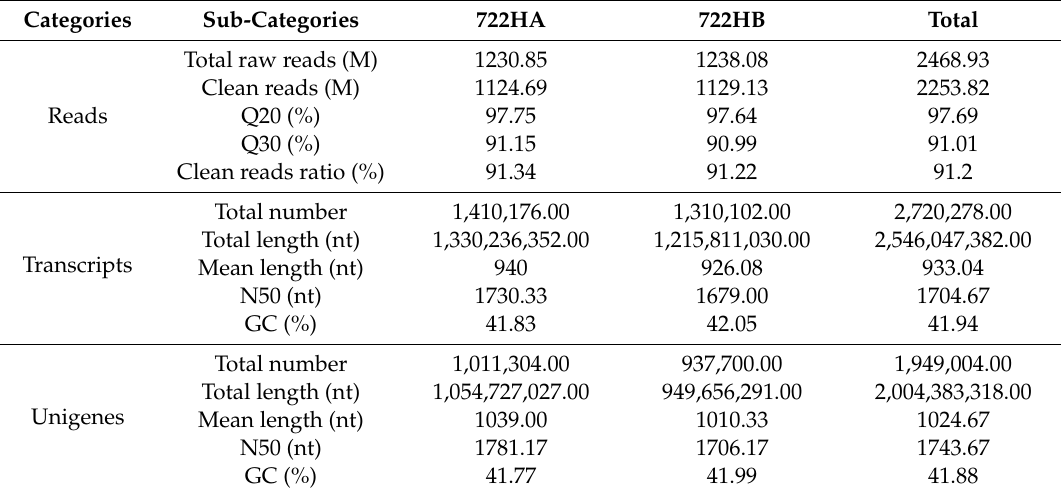
Table 1. Results of de novo